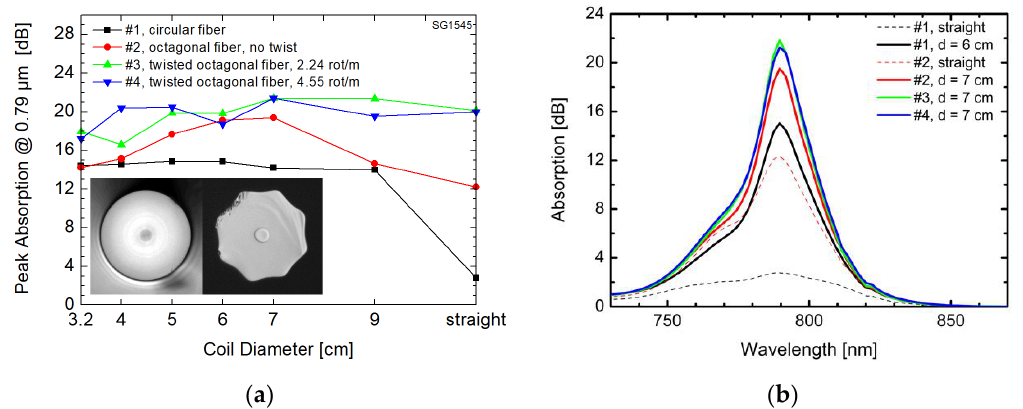
Figure 4. ( a ) Peak absorption versus coil diameter for four different fiber samples drawn from the same preform. Fiber cross sections are apparent from the microscope photographs in the inset; ( b ) Spectral absorption around the pump wavelength of 0.79 µm for selected coil diameters of the same four fiber samples.